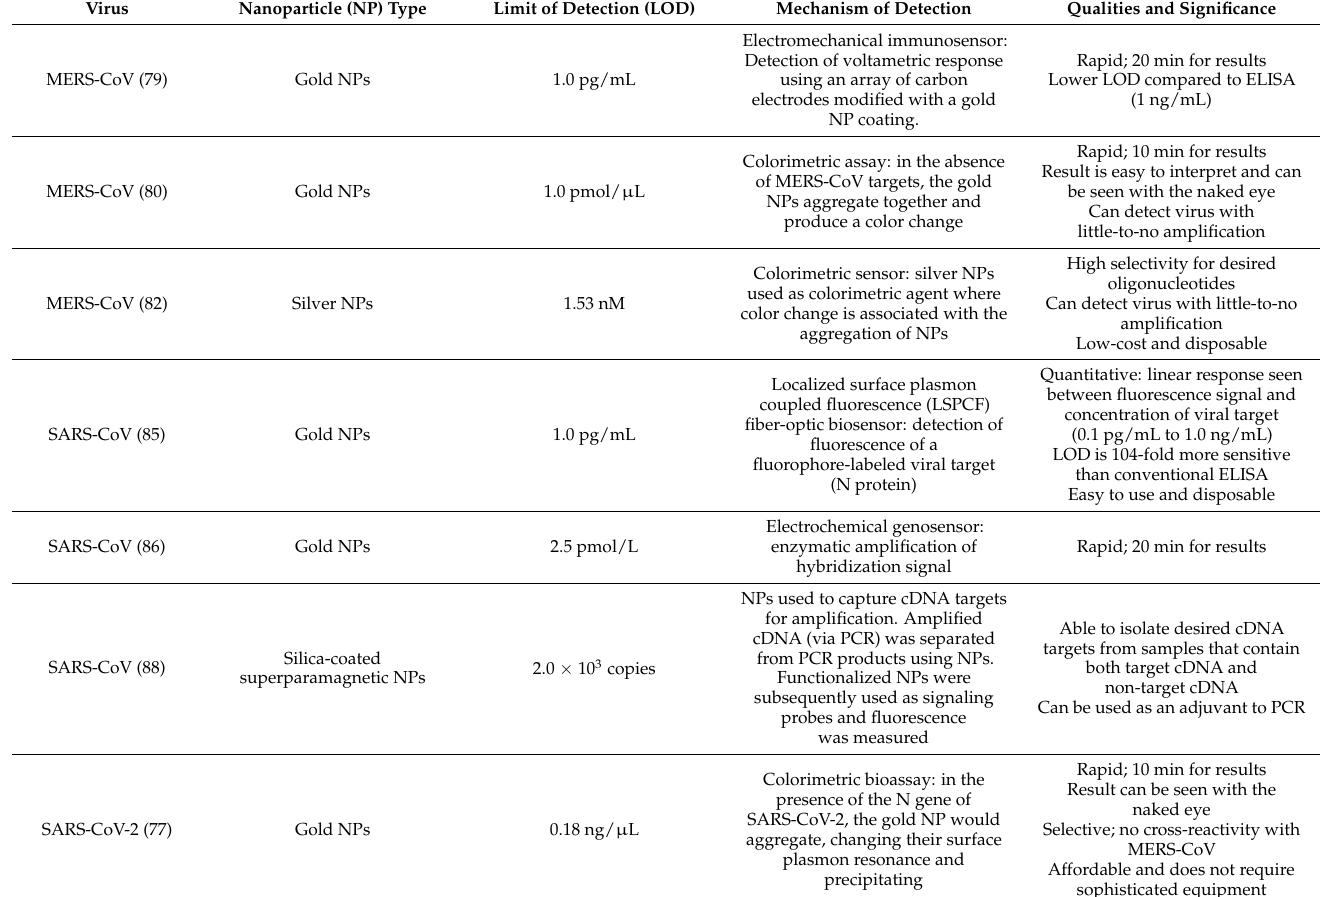
Table 1. Highlights of nanoparticles/nanotechnologies-based diagnostic methods for